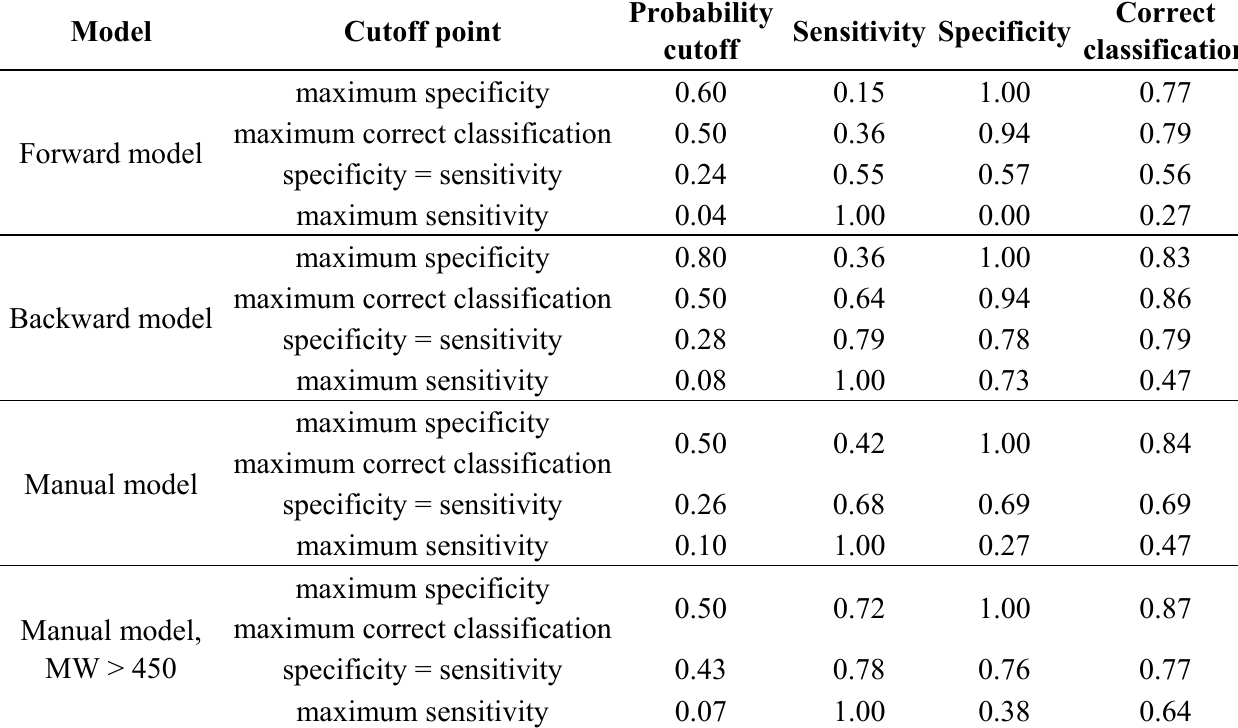
Table 2. Effect of LR probability cutoff on model